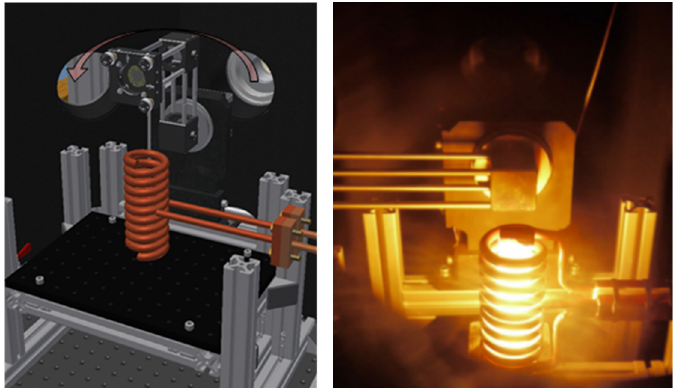
Figure 7. Scheme of the setup of the inductor inside the vacuum vessel with movable mirror arm on the left and photo of inductor with heated reference blackbody on the right.